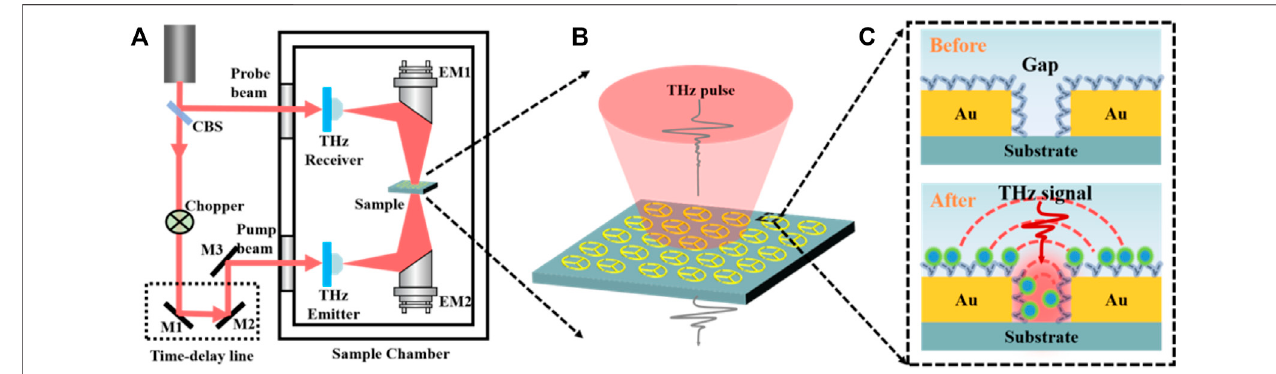
FIGURE 2 | Schematic of the experimental setup and the sample. (A) THz-TDS and the magni fi ed pictures of the sample (B) and the dotted rectangle (C) which contains Au structures and air gaps before and after the combination of the S1 protein.